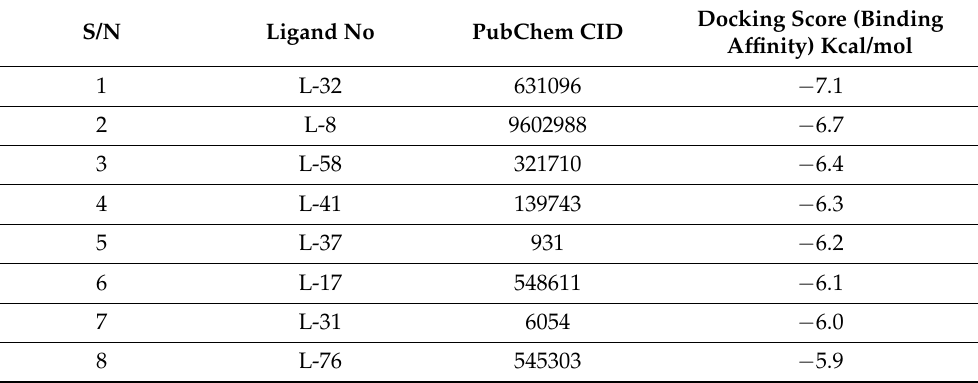
Table 3. Ligand no. and PubChem CID of the top 8 molecules based on docking score binding affinity.